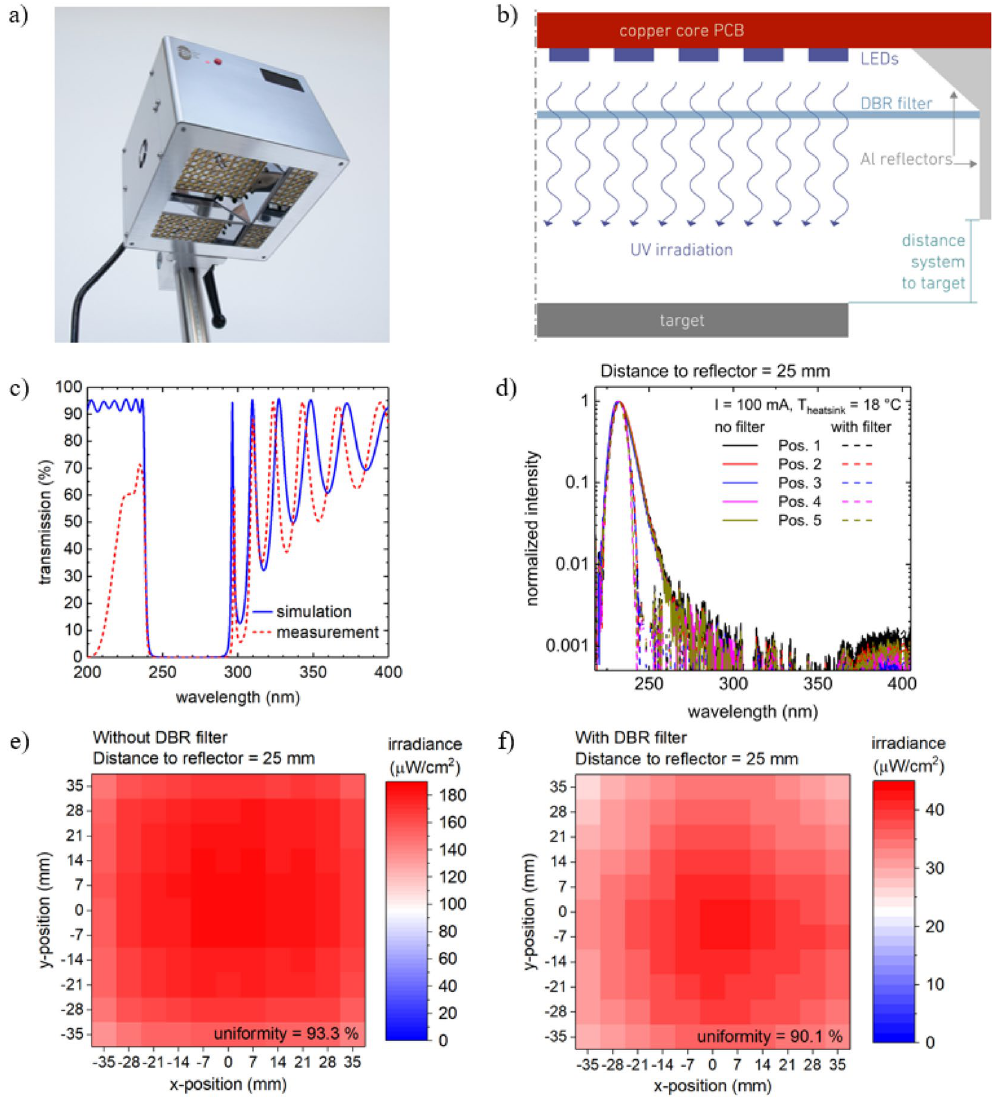
Figure 2. ( a ) Picture of the completely assembled far-UVC LED irradiation system where the radiation unit with the LEDs and the vertical and slanted reflectors are visible. ( b ) Half of a cross section schematic of the optical components of the far-UVC LED radiation unit. ( c ) Simulated (blue curve, solid line) and measured (red curve, dashed line) transmission spectra of the DBR filter under normal incidence. ( d ) Emission spectra measured at the maximum operation current of the LEDs (100 mA), at a distance of 25 mm from the lower edge of the vertical reflector and at five different positions (center (Pos. 1) and four corners of the LED array (Pos. 2–5)). ( e ) and ( f ) The irradiance distribution of the far-UVC LED irradiation system on a 70 mm × 70 mm target area measured ( e ) without and ( f ) with the DBR filter at the maximum operation current of the LEDs (100 mA) and at a distance of 25 mm from the lower edge of the system. In both cases the uniformity (defined as 100% − (standard deviation/mean value of the irradiance)) is >